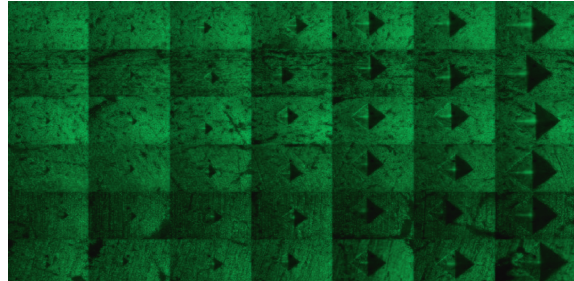
Figure 10: Micro-Vicker indentation on the composite samples.